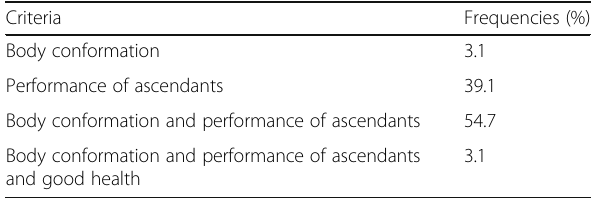
Table 5 Selection criteria for breeding females